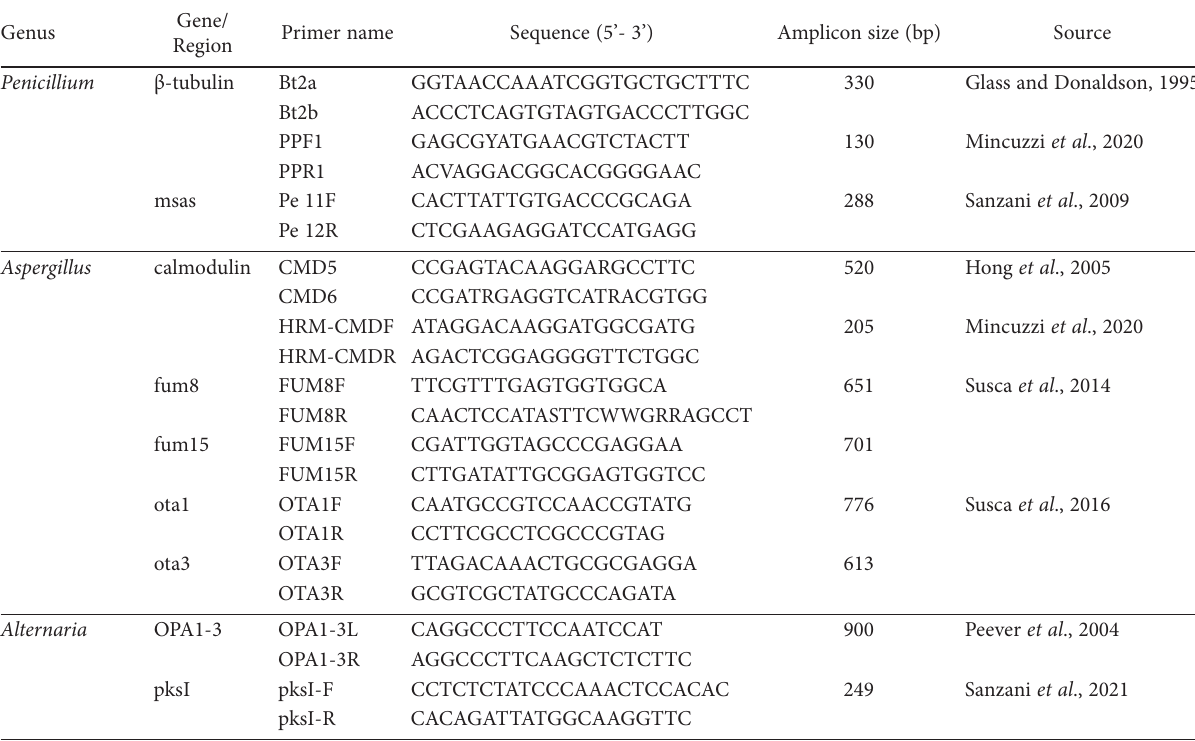
Table 1. Primers for HRM screening, sequencing, and mycotoxin gene detection of Penicillium , Aspergillus and Alternaria isolates from grape